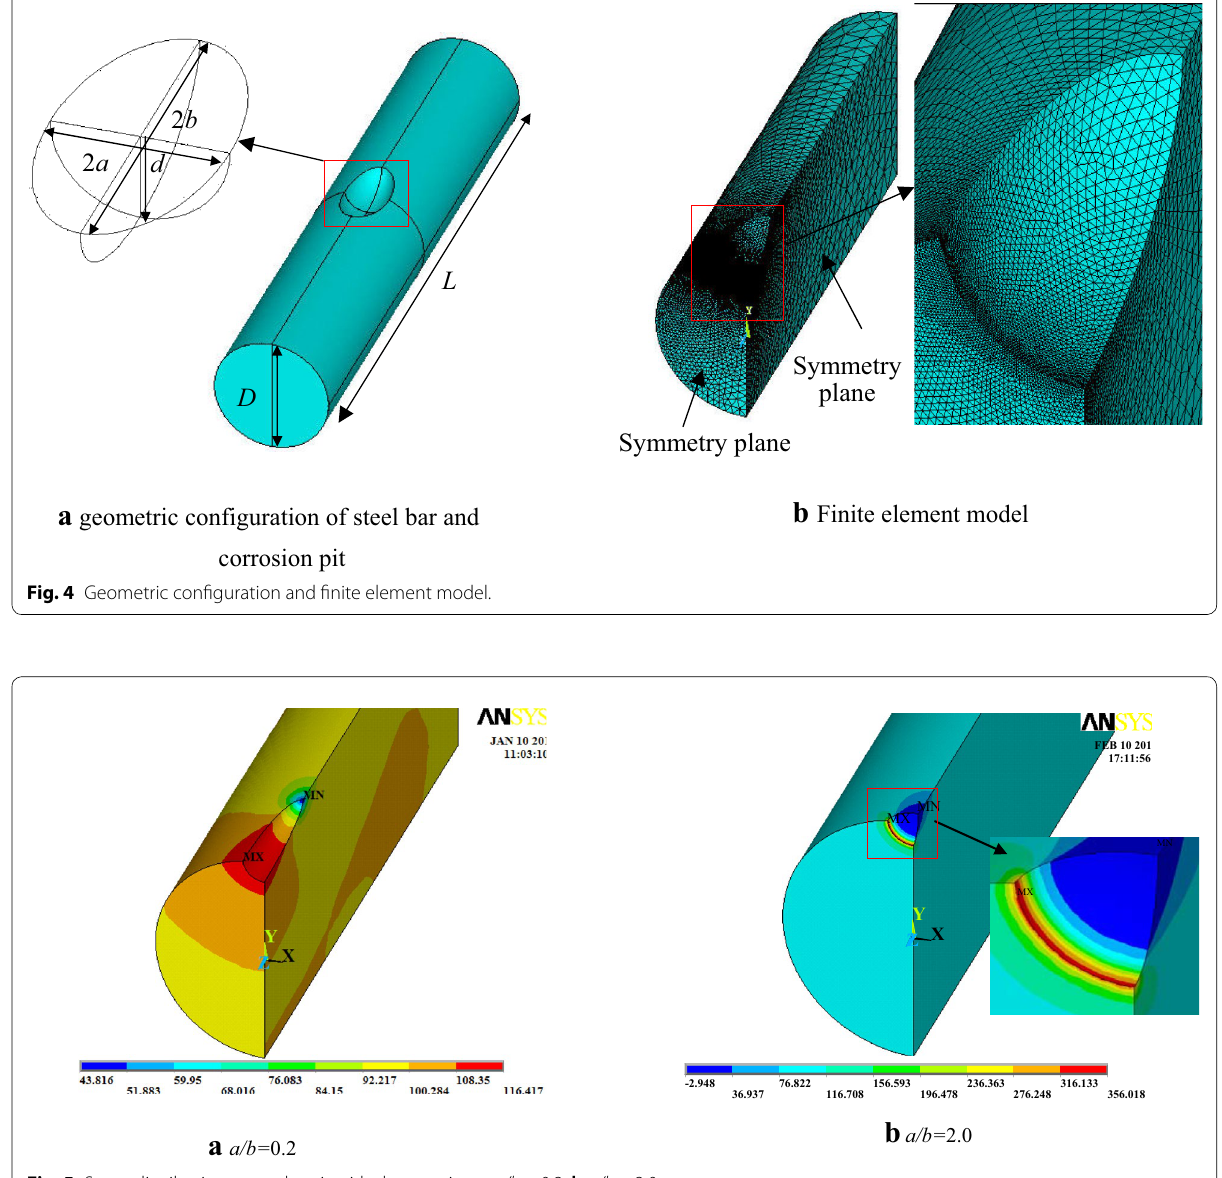
Fig. 5 Stress distributions near the pit with shape ratios: a a/b